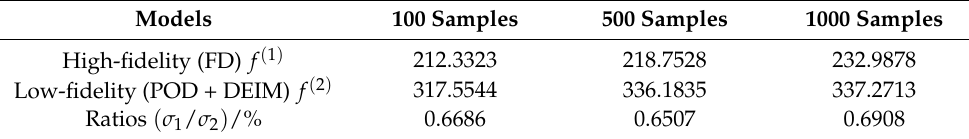
Table 4. Comparison of sample variances by 100, 500 and 1000 samples,